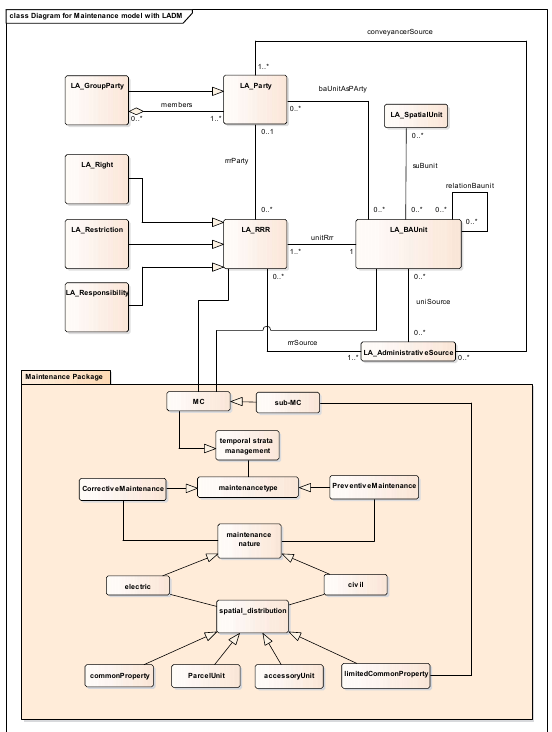
Figure. 3 Maintenance Domain model with LADM